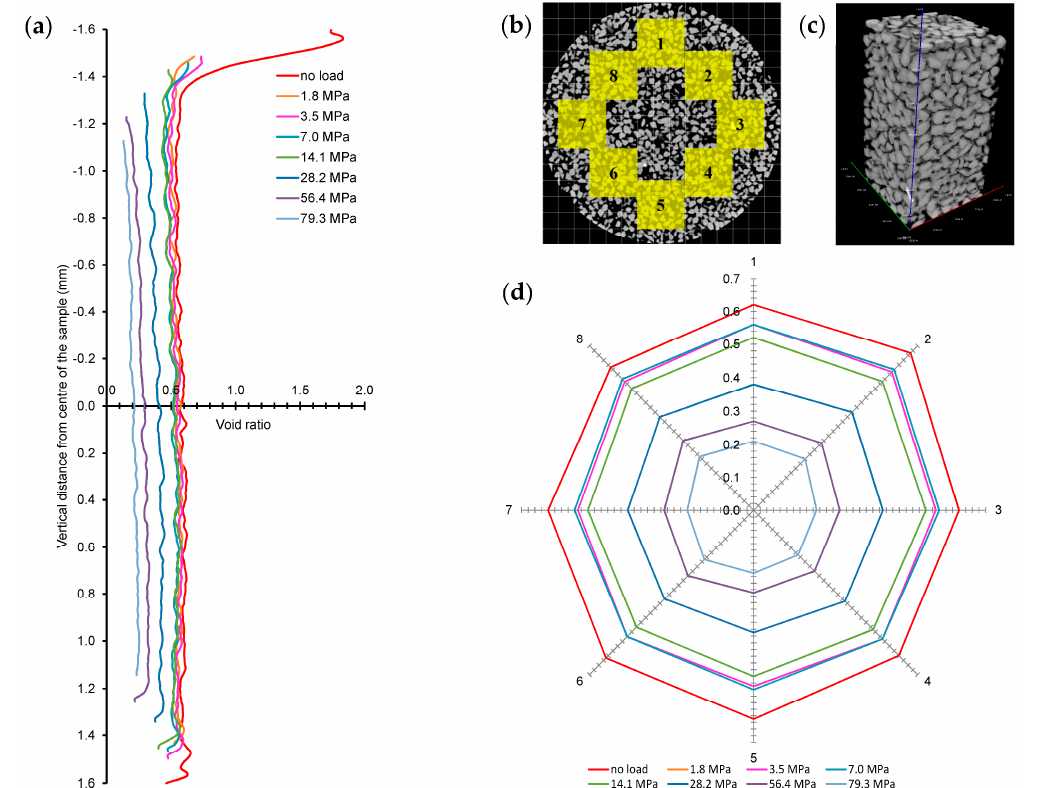
Figure 8. ( a ) Change of void ratios along the height of the sample with increased vertical stresses; ( b ) Locations of eight sub-volumes selected for spatial analysis; ( c ) 3D image of a sub-volume; ( d ) Spatial distribution of void ratios of sub-volumes with increased vertical stresses.